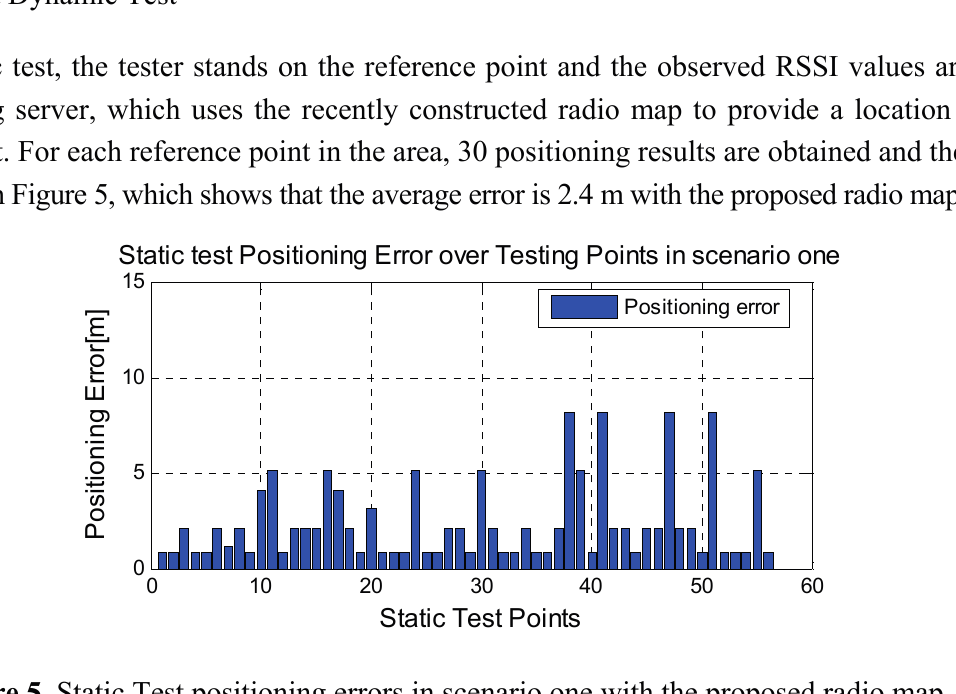
Figure 5. Static Test positioning errors in scenario one with the proposed radio map.